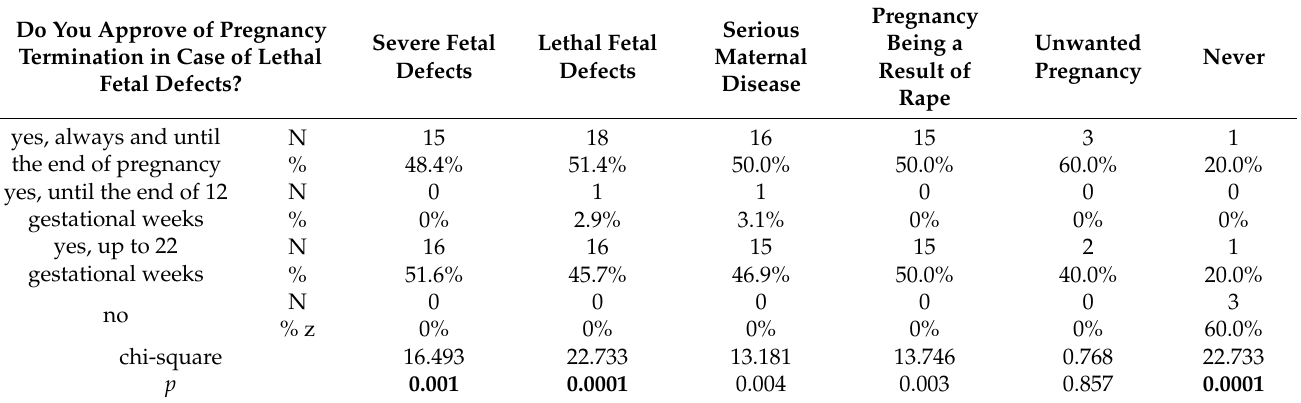
Table 4. Approval of pregnancy terminations in case of lethal fetal defects vs. approval of other indications for terminations (N =